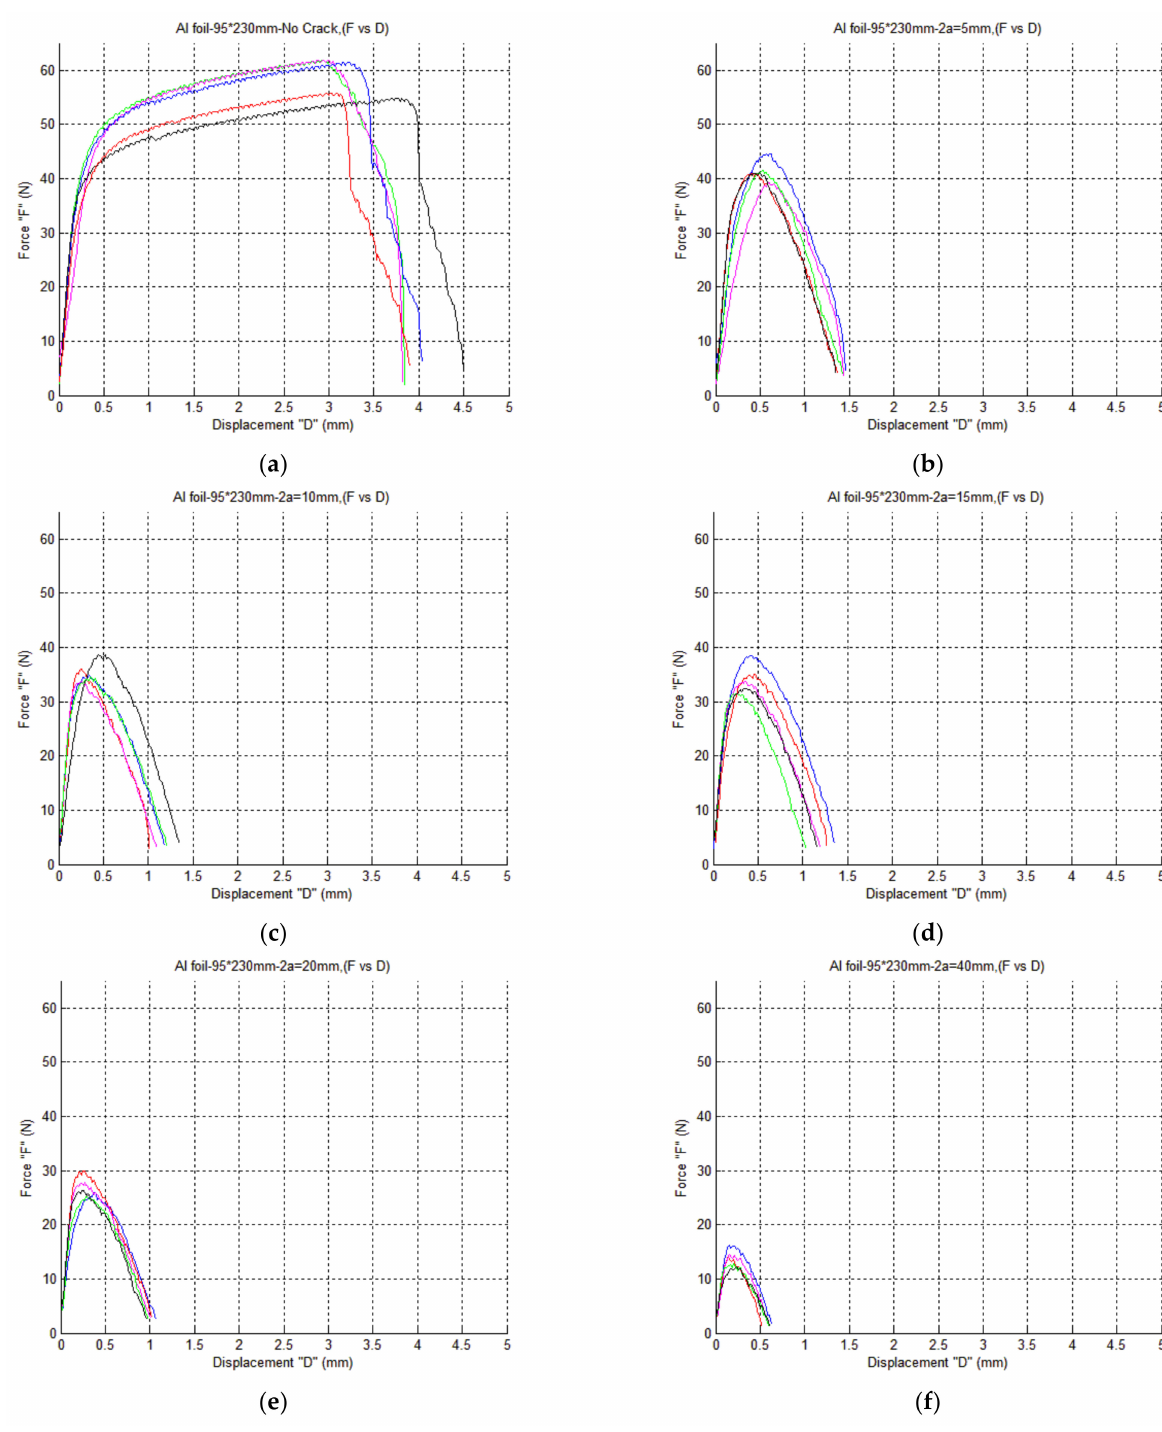
Figure A1. Experimental results for aluminum foil. ( a ) F vs. D for 0 mm crack, ( b ) F vs. D for 5 mm crack, ( c ) F vs. D for 10 mm crack, ( d ) F vs. D for 15 mm crack, ( e ) F vs. D for 20 mm crack, ( f ) F vs. D for 40 mm